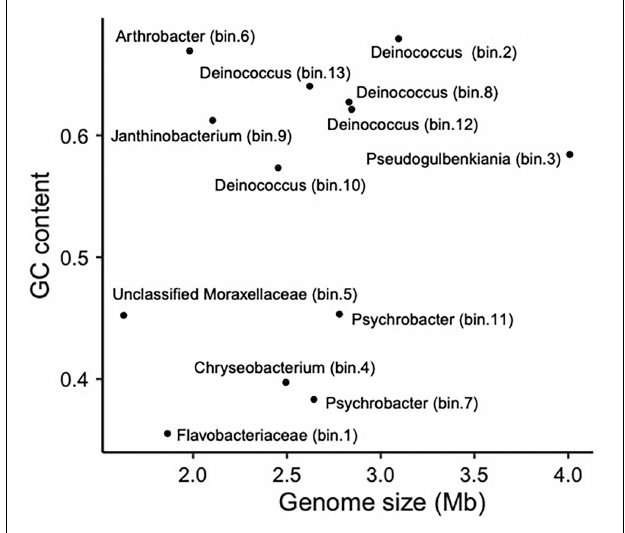
FIGURE 4 | Scatter plot showing the relationship between genome size (Mb) and GC content (i.e., proportion of G and C sites) for sequenced